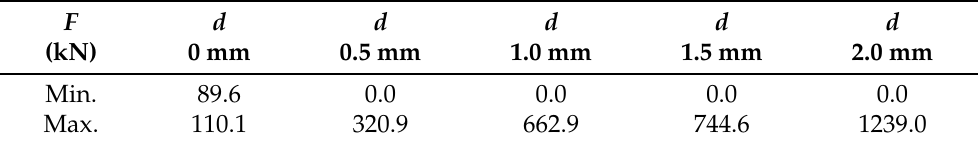
Table 4. Dynamic load on the slab track for different wheel flat depths (V = 360